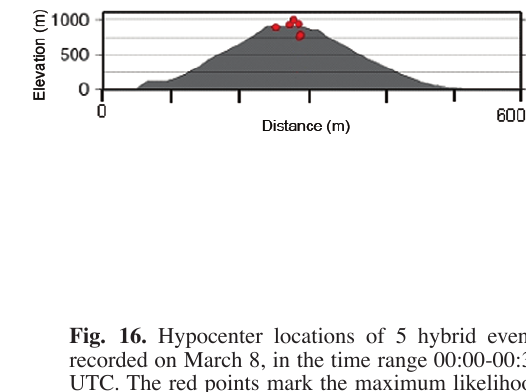
Fig. 16. Hypocenter locations of 5 hybrid events recorded on March 8, in the time range 00:00-00:30 UTC. The red points mark the maximum likelihood hypocenters, the blue squares indicate the seismic The second swarm started on March 20, at about 9:20 UTC, with an occurrence rate of one event every 2 min. The occurrence rate rapidly increased while the amplitude decreased. This